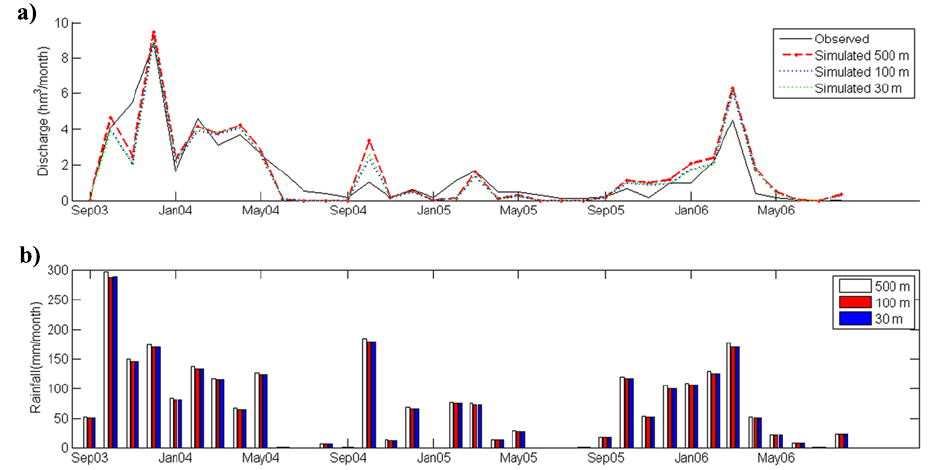
Fig. 3. (a) Observed and simulated monthly flow volume for each cell size, and (b) monthly rainfall, for the period 2003–2006.